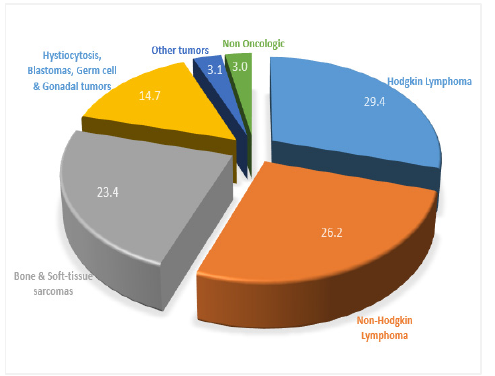
Figure 1. Distribution of 18 F-FDG PET/CT pediatric examinations based on a 10-year workflow from the Division of Nuclear Medicine, Biomedical Research Foundation of the Academy of Athens (BRFAA). About half of 18 F-FDG PET/CT exams concern lymphomas, and almost a quarter concerns sarcomas, representing the overwhelming majority of PET imaging in pediatrics.